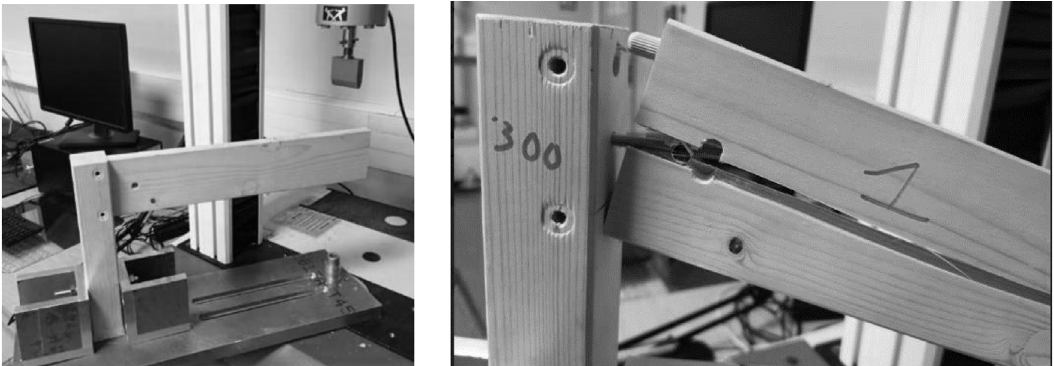
Fig. 6. One-screw assembly: (left) experimental test con fi guration and (right) resulting failure mode.